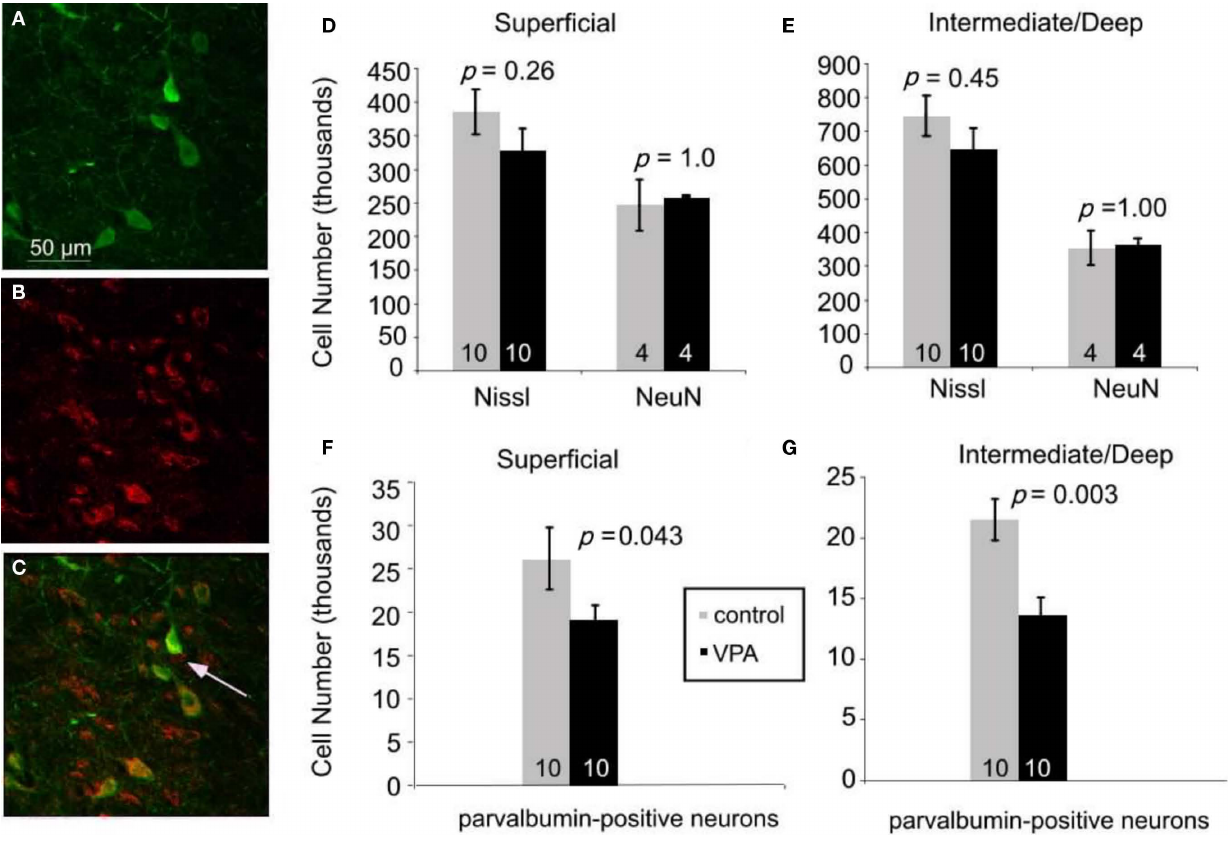
FIGURE 5 | Immunofluorescence double staining for parvalbumin [green, (A)], GABA [red, (B)], and their colocalization [yellow, (C)]. 95% of neurons expressing parvalbumin also express GABA. Arrow in (C) denotes a GABAergic neuron that is not parvalbumin-positive. Scale bar = 50 μ m. (D–G) . Effects of prenatalVPA treatment on cell numbers in the superior colliculus of adult rats. (D,E) .Total number of